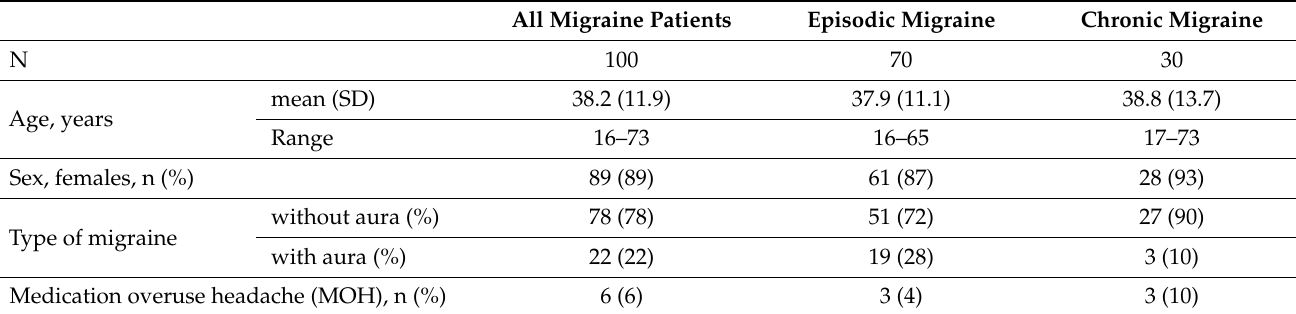
Table 1. Characteristics of the studied